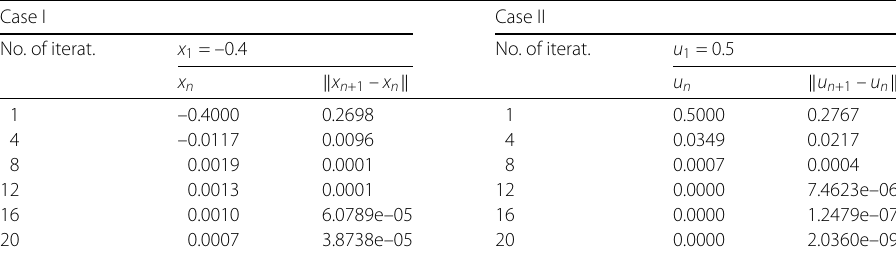
Table 1 Numerical outcomes of Example 6.1 Case I Case II No. of